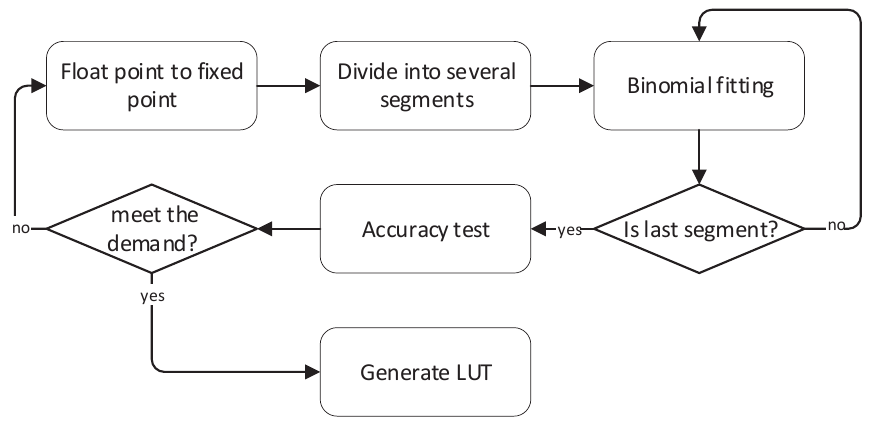
Figure 1. The flow chart of the methodology.